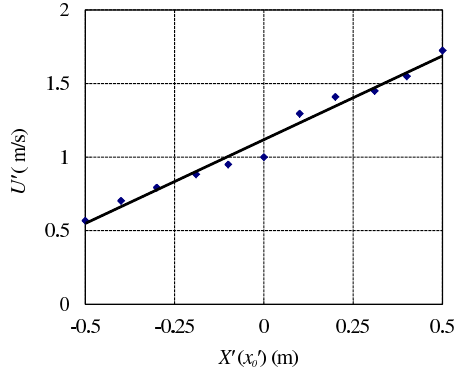
Fig. 4. Experimental relationship between the mean underwater ve- locity U 0 and the release distance X 0 obtained by Di Risio et al. (2009) for an ellipsoidal landslide. Diamonds show experimental measurements, the bold line the relevant linear regression Eq. (37). Note that U 0 ≈ 1 ms − 1 for X 0 =